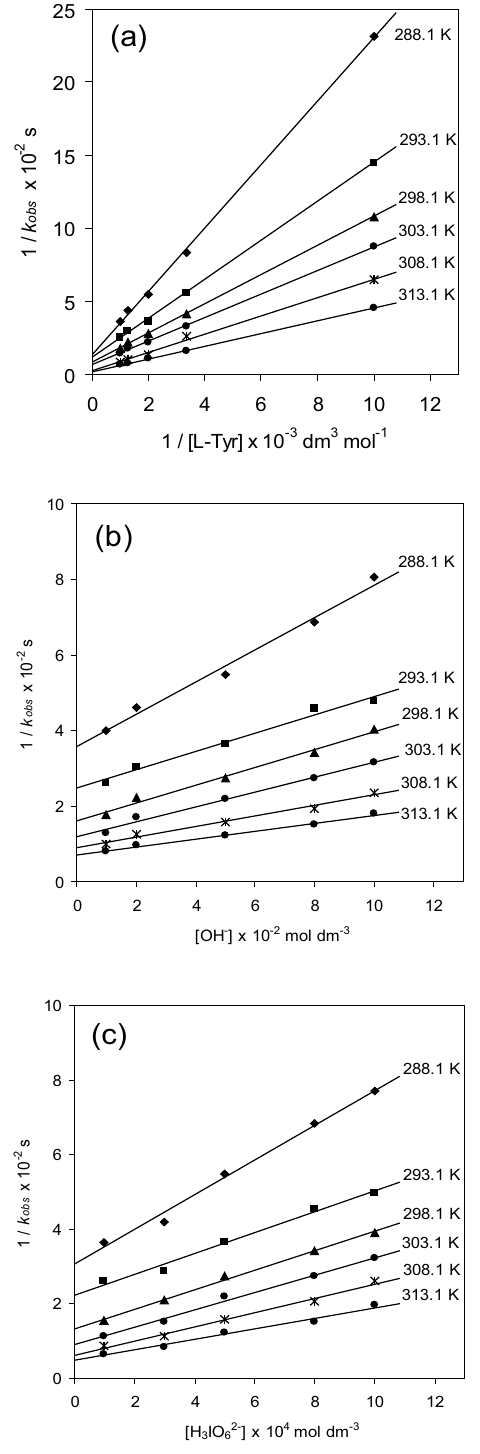
Figure 7. Plots of 1/ k versus (a) 1/[L-Tyr], (b) [OH - ] and obs (c) [H